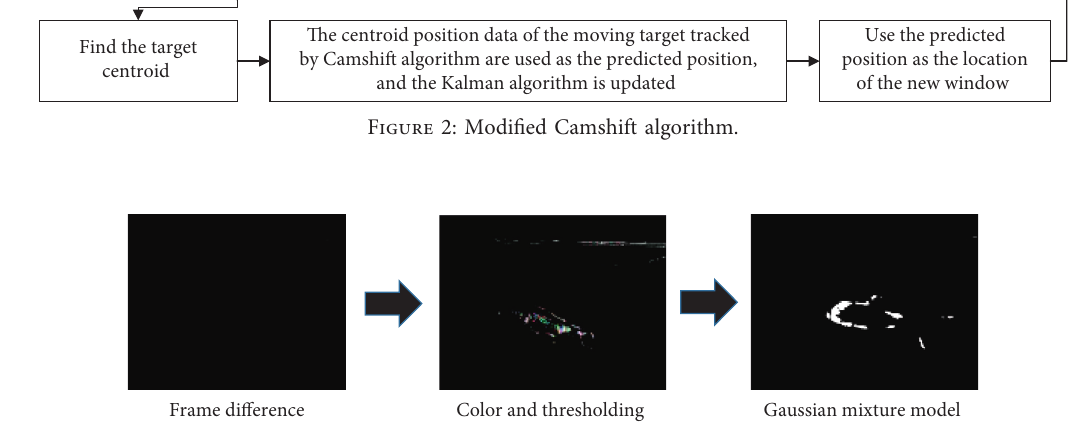
Figure 3: Results for posture recognition based on the frame difference method.